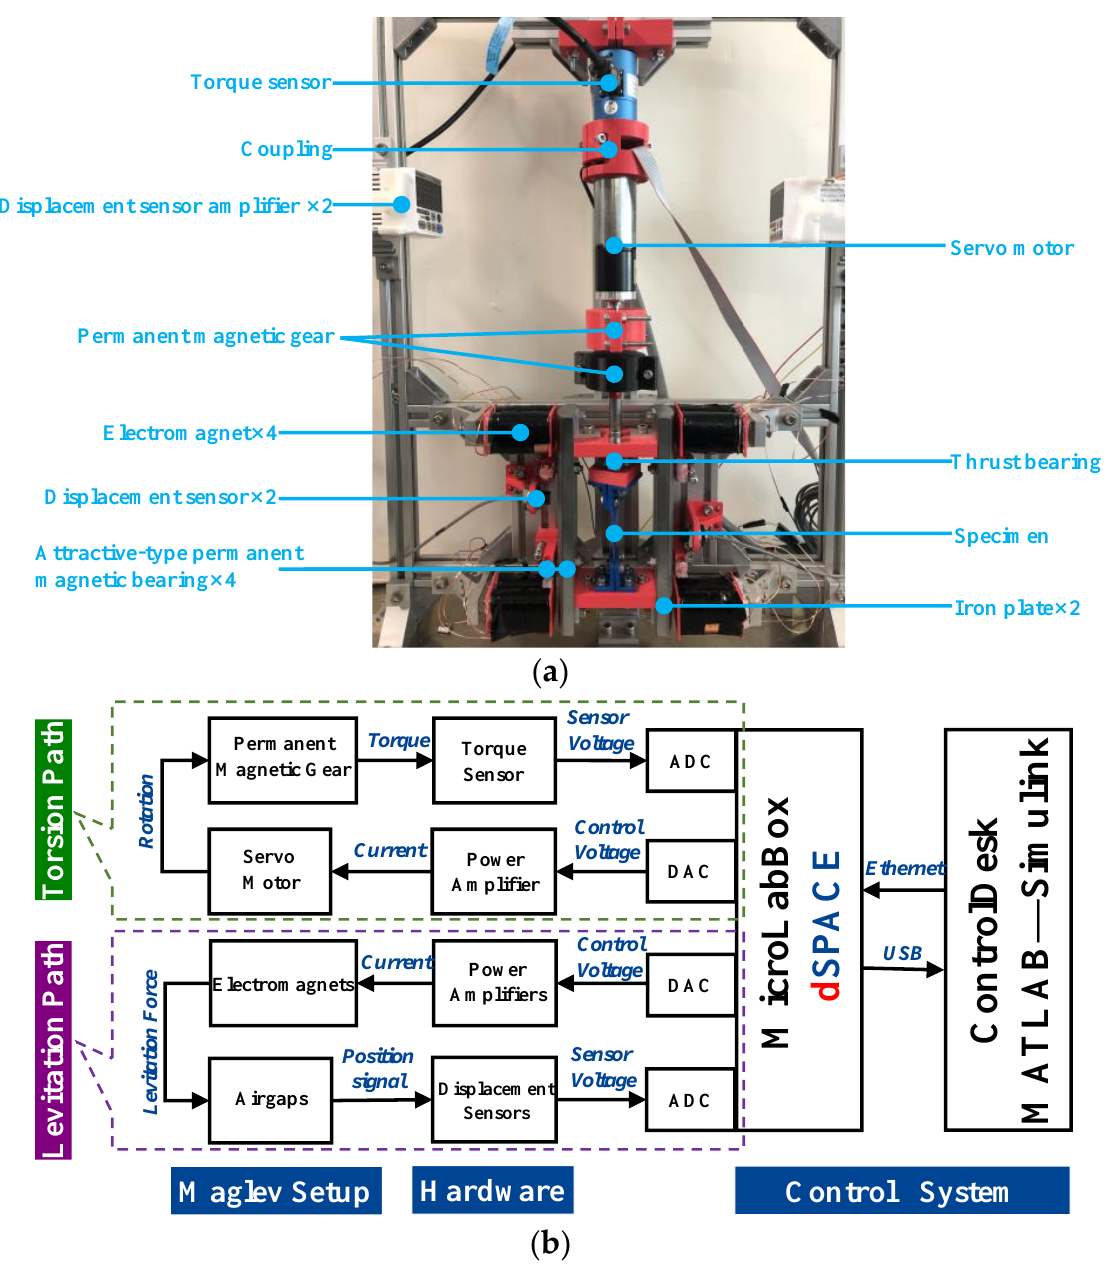
Figure 11. Experiment setup: ( a ) A Photograph of the experiment setup ( b ) Overall system structure diagram.